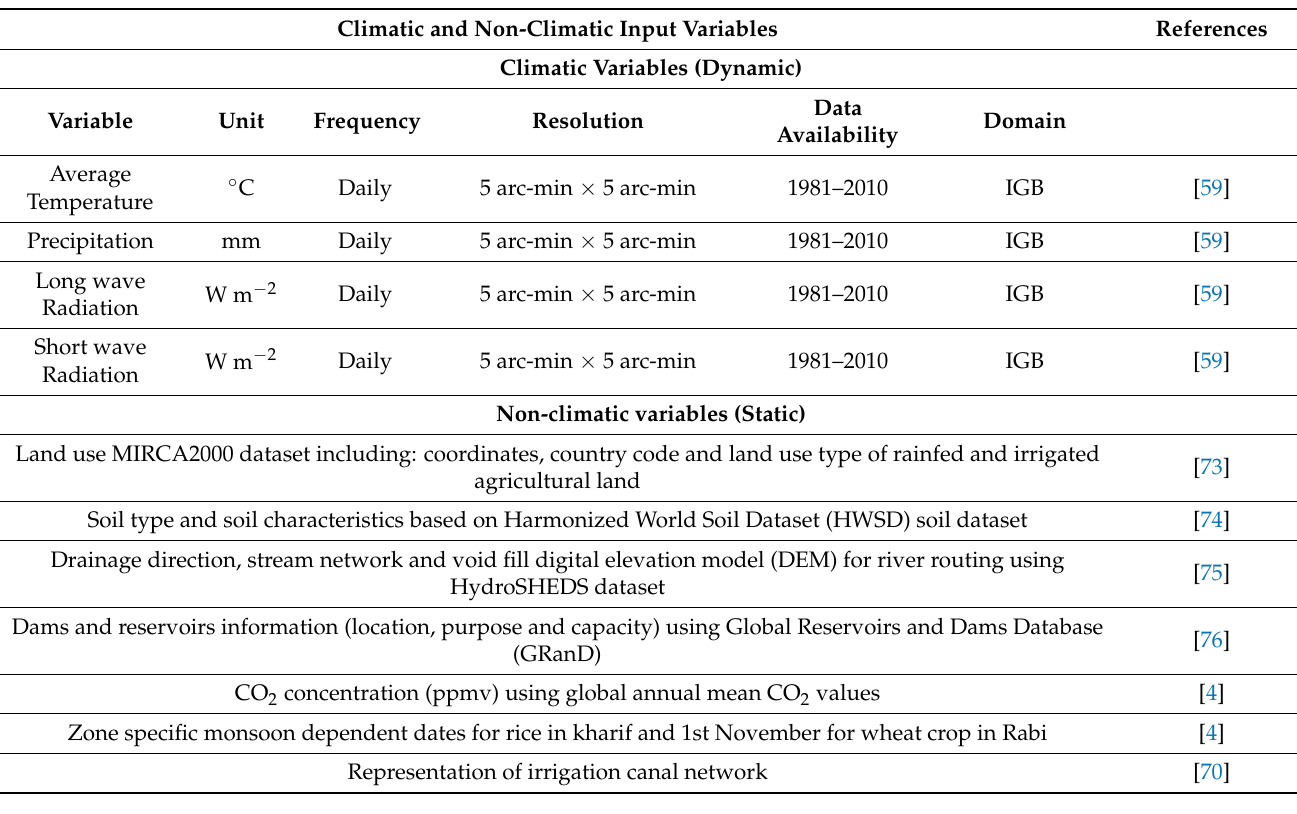
Table 1. List of climatic and non-climatic input variables. Climatic and Non-Climatic Input